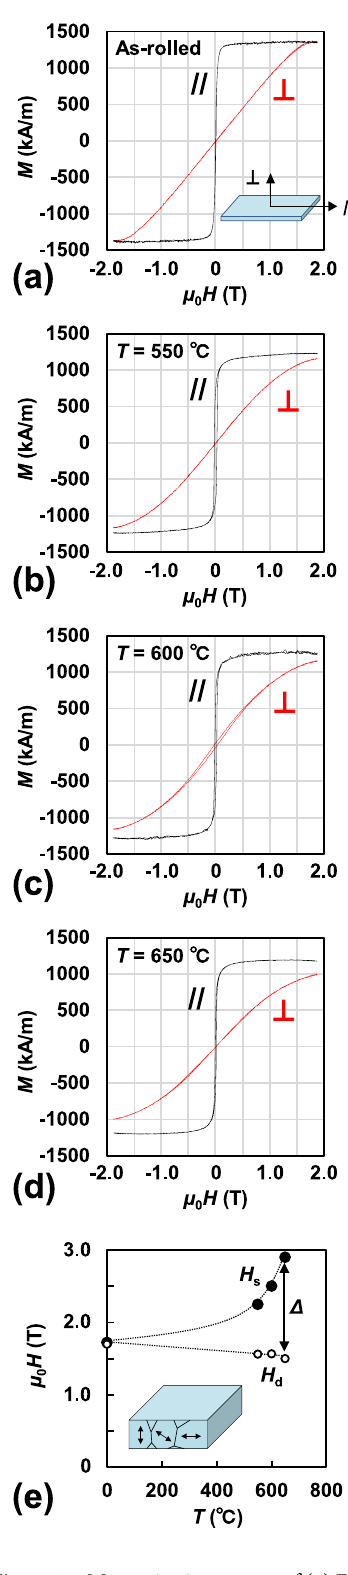
Figure 7. Magnetisation curves of ( a ) Fe–Co–V foil (as-rolled) and Fe–Co–V–N foils nitrided at T = ( b ) 550, ( c ) 600, and ( d ) 650 °C. The magnetic field was applied parallel (//) and perpendicular ( ┴ ) to the sample plane, as shown in the inset of ( a ). ( e ) H s and H d of Fe–Co–V–N foils plotted as functions of T . Δ is the difference between H s and H d . The plots at T = 0 correspond to the as-rolled sample. The schematic image of the texture is shown in the inset of ( e